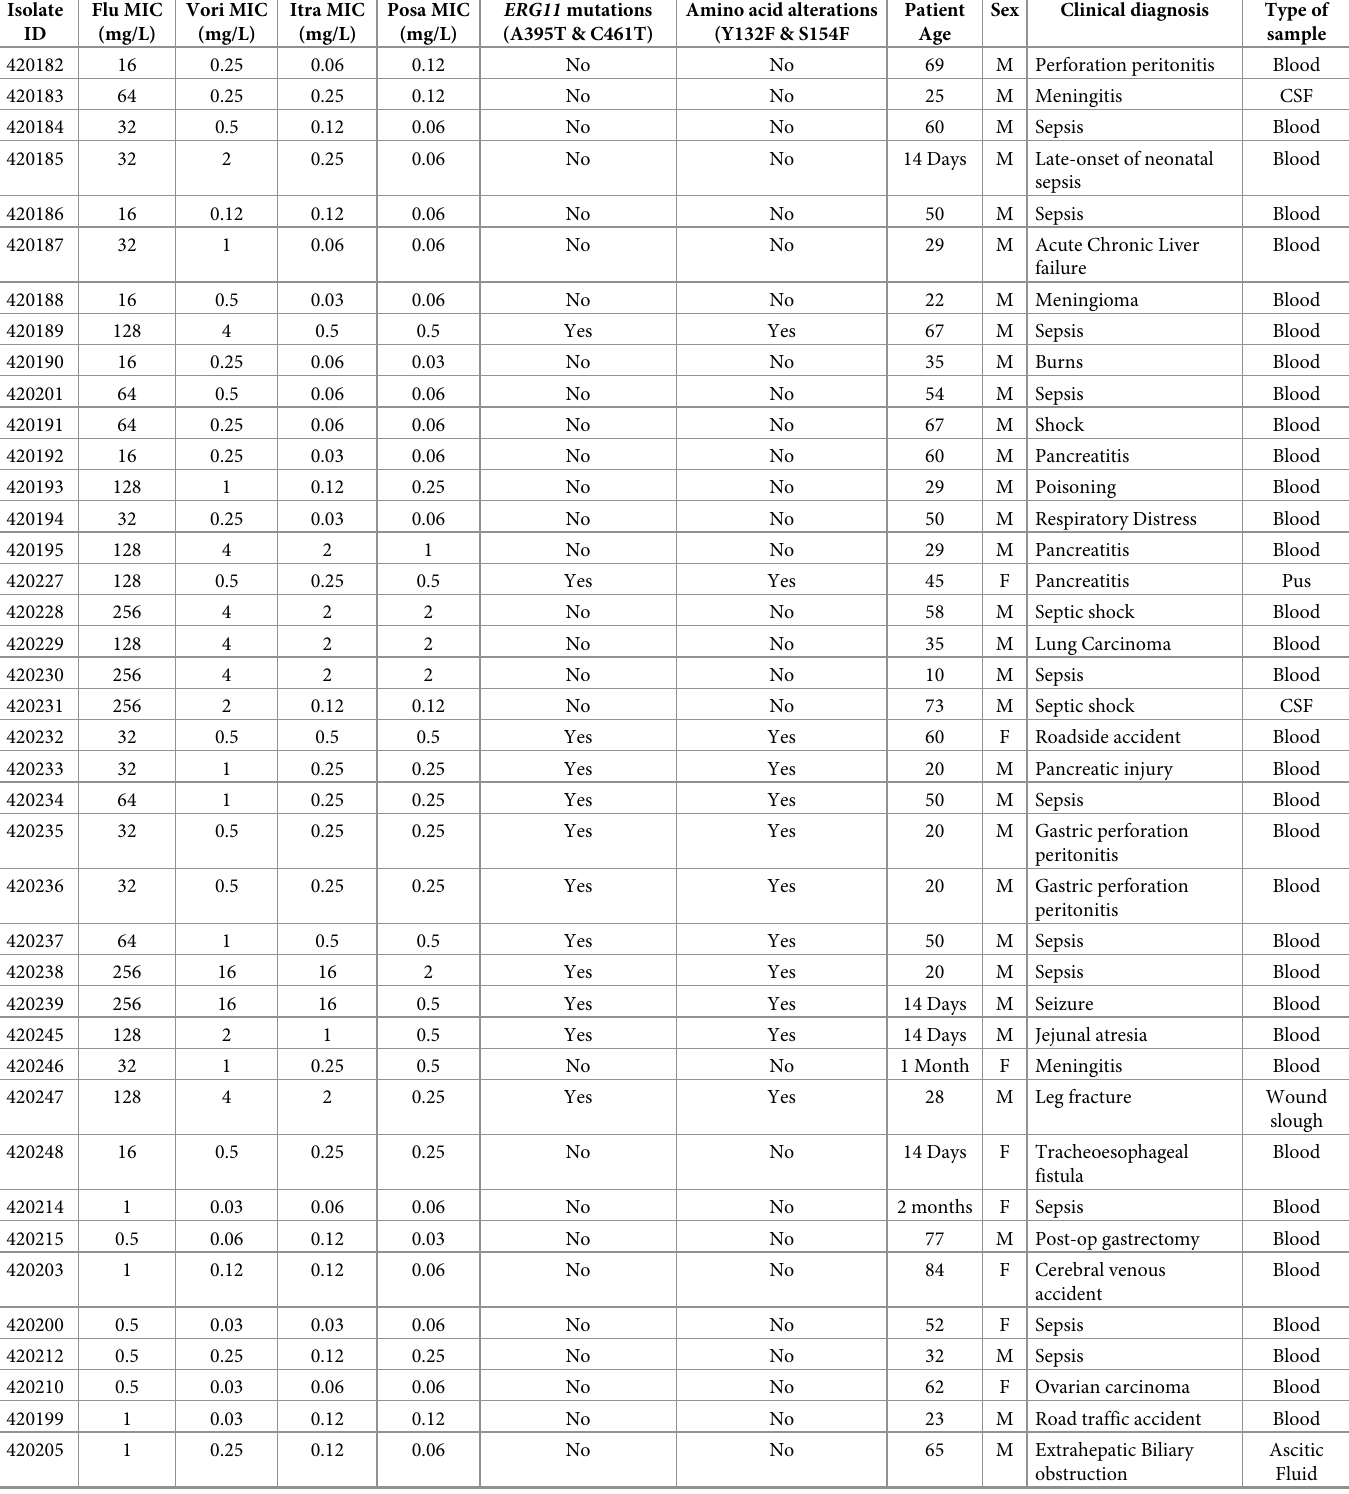
Table 1. Details of isolates with clinical